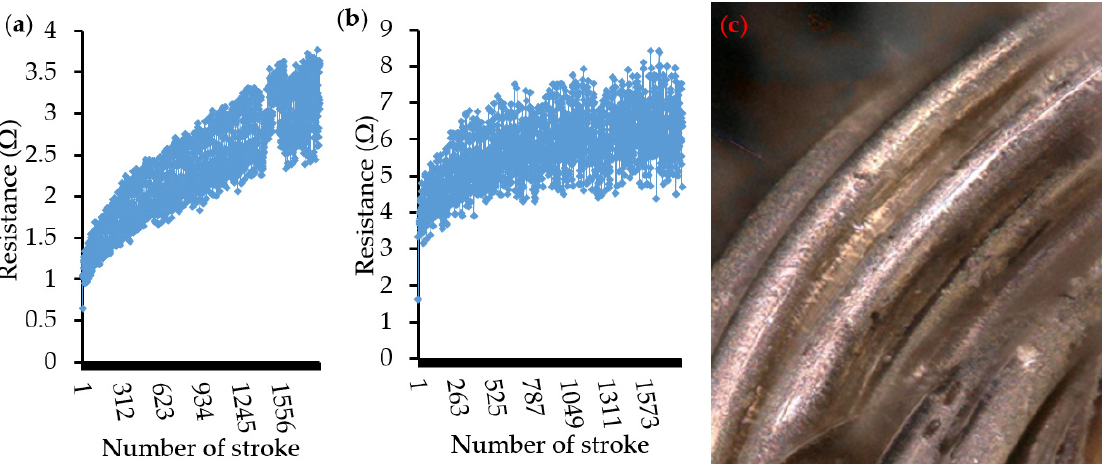
Figure 4. Resistance as a function of stroke number. ( a ) Rub 0–1000 Rub (1837 stroke). The surface temperature rose by 4.2 °C during these experiments. ( b ) Rub 4000–5000 Rub (1821 stroke). The surface temperature rose by 5.4 °C for these ex- periments. ( c ) Microscope image of the surface fibers after 5000